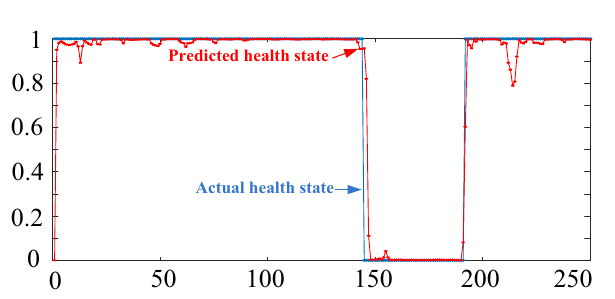
Figure 3. Predicted health status based on the proposed